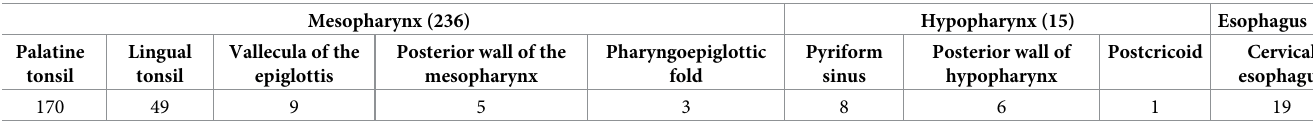
Table 1. The locations of the fish-bone foreign